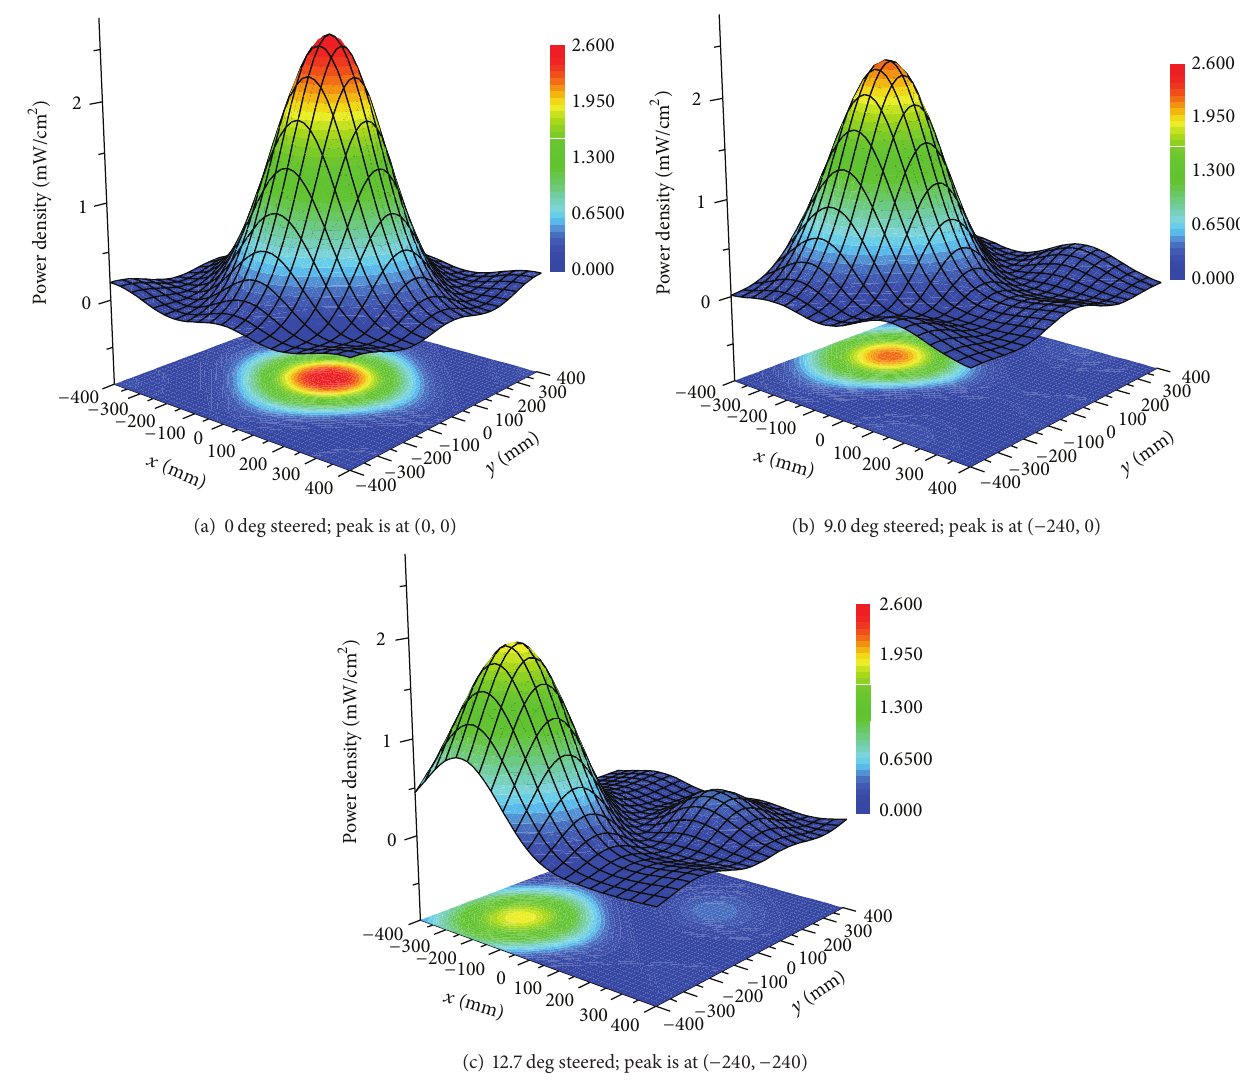
Figure 5: Computed power density distribution.